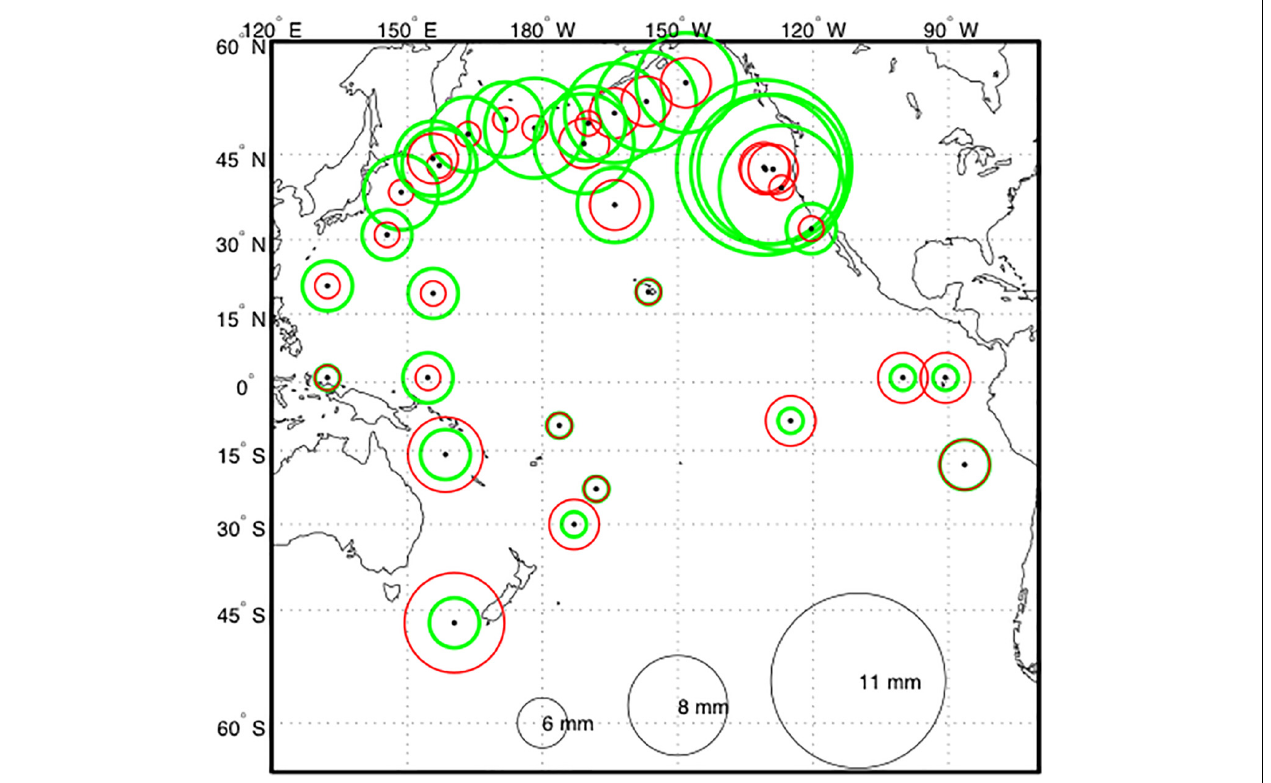
FIGURE 7 | Mean summer (winter) infragravity significant wave heights in red (green), represented by the size of each circle. Seasonal averages of infragravity waves at periods of 1.5 to 20 minutes measured at DART stations (Aucan and Ardhuin, 2013). Permission obtained for use of figure.